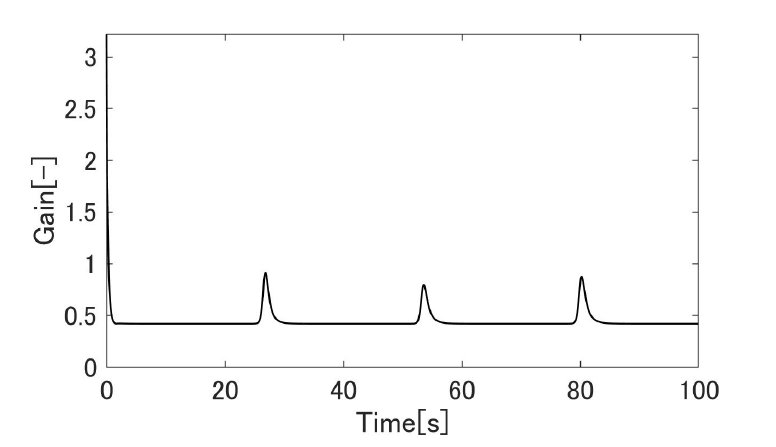
Figure 14. The comparison of output angles θ .